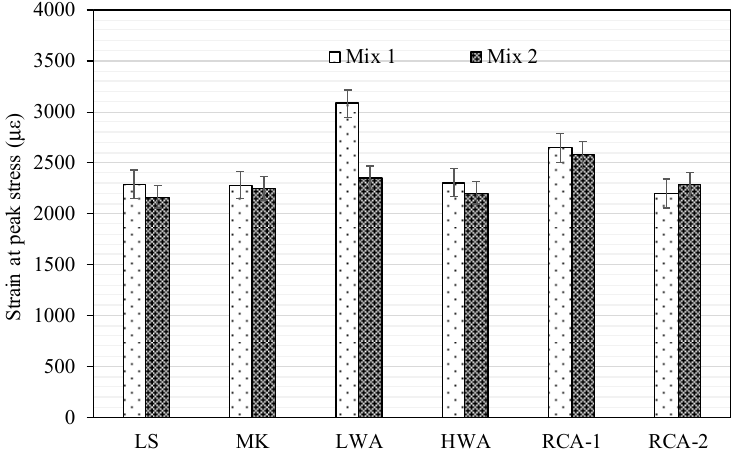
Figure 7. Strain at peak stress for Mix 1 and Mix 2.